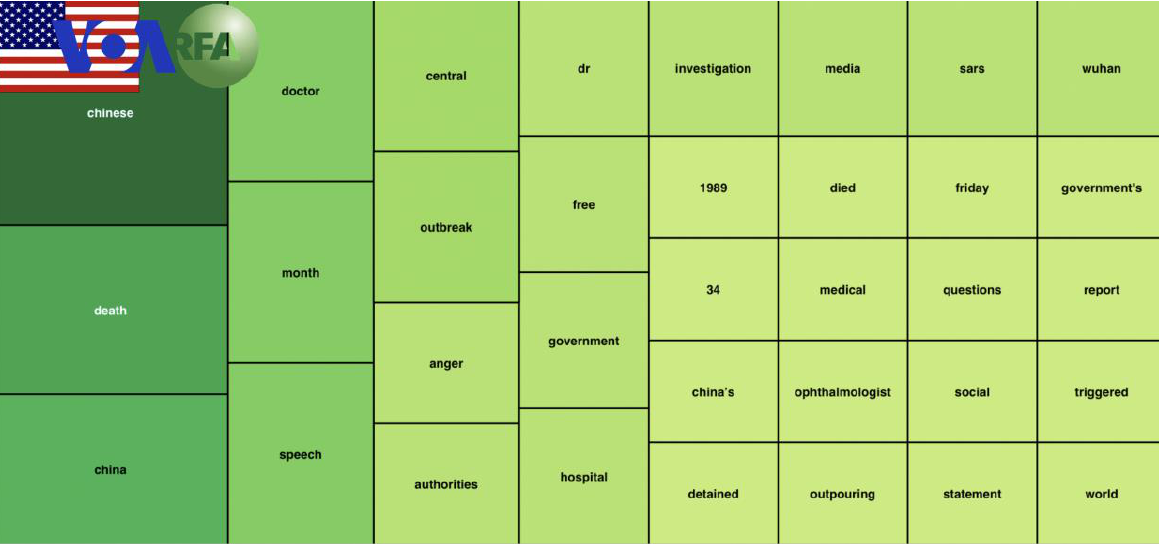
Figure 5 : Words frequently used in Facebook posts mentioning Li Wenliang by Chinese media (top) U.S. mainstream media (middle) and U.S. government- funded media (bottom); Excludes Li Wenliang’s name and the term “coronavirus” for better visibility of other